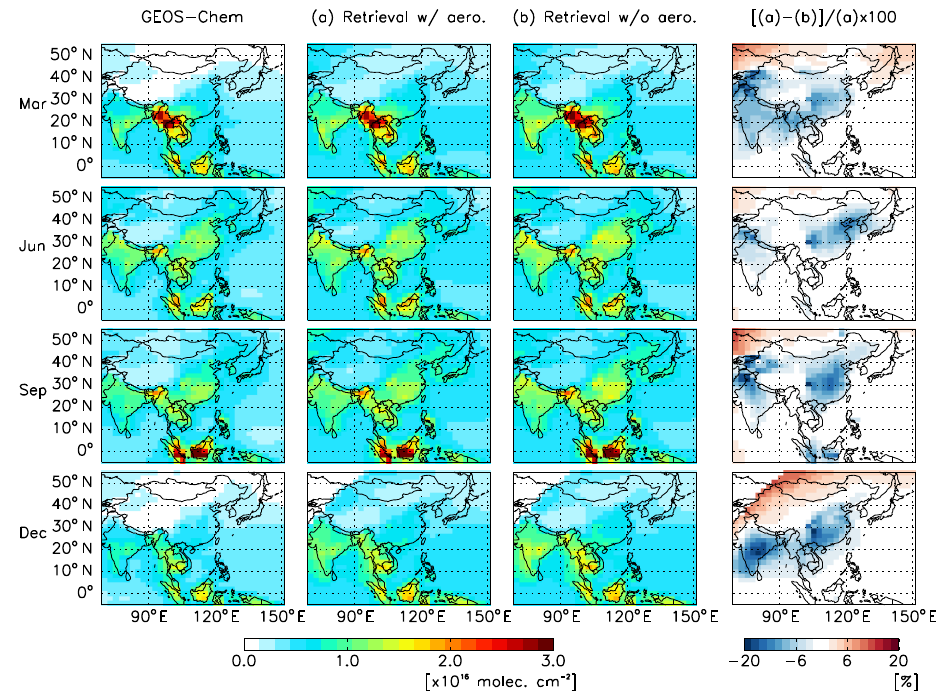
Figure 2. HCHO vertical column densities (VCDs) simulated from GEOS-Chem (first column) and retrieved HCHO VCDs using AMFs with aerosols (second column) and without aerosols (third column) for a month of each season in 2006. Relative differences between the two retrievals using AMFs with and without aerosols are shown in the fourth column representing the aerosol effect on the retrieved HCHO